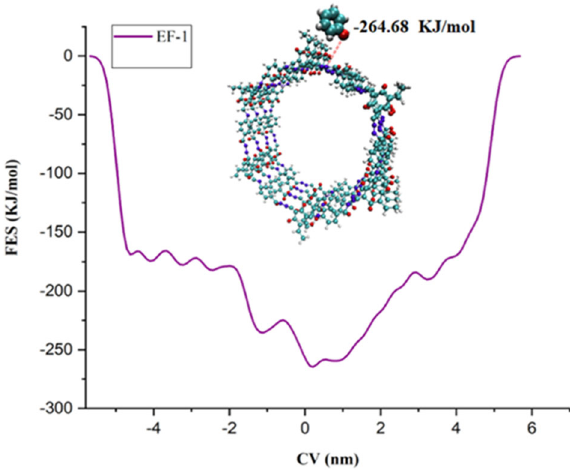
Fig. 6 The free energy pro fi le with imposing an electrical fi eld at 1 V nm − 1 condition.